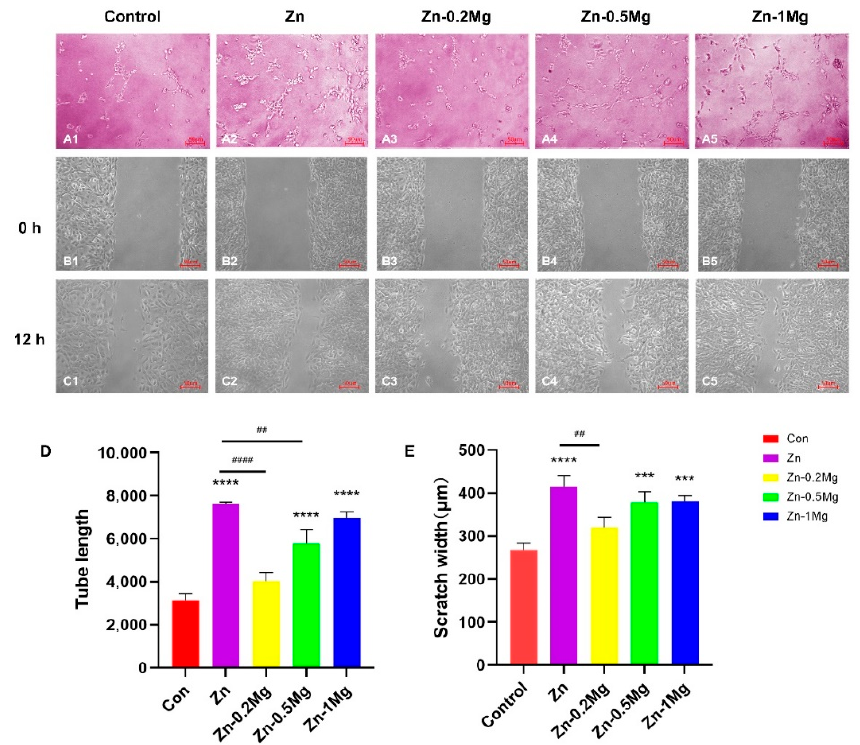
Figure 7. In vitro angiogenesis assessment. ( A1 – A 5 were pictures of VECs forming vascular rings, B1 – B 5 were pictures of cell migration of MC3T3-E1 at 0h, C1 – C 5 were pictures of MC3T3-E1 at 12h) Quantification of tube formation tests and ( D ) corresponding tube lengths of various extract groups. The results of ( B , C ) the VEC migration test and ( E ) their migration width (um) after 12 h of incubation (**** p < 0.0001, *** p < 0.001, compared with the control group; #### p < 0.0001, ## p < 0.01 compared with the Zn group).